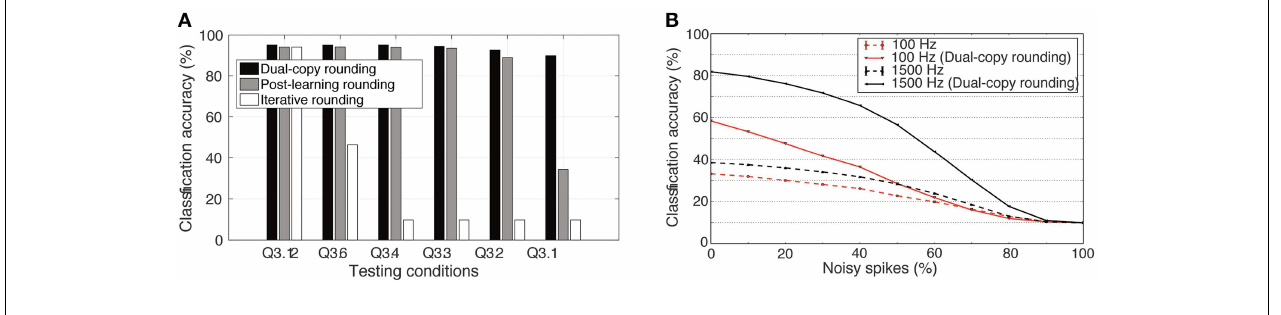
during training can prevent learning entirely at low-precision regimes. The results show averages of five independent runs with different random seeds. (B) Increase in classification accuracy of a spiking DBN with Q3.1 precision weights due to the dual-copy rounding method for input rates of 100 and 1500Hz. Results over four